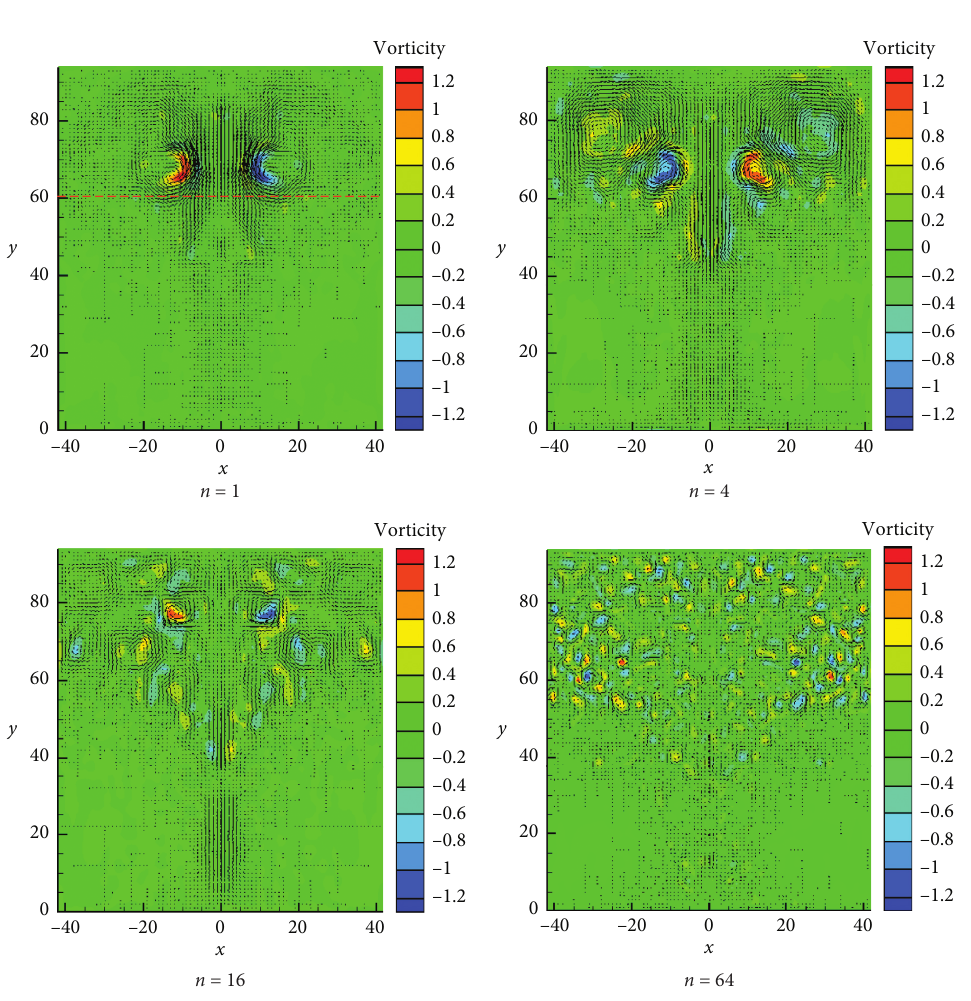
Figure 8: The single POD mode at 20g oscillation acceleration under 70% fill